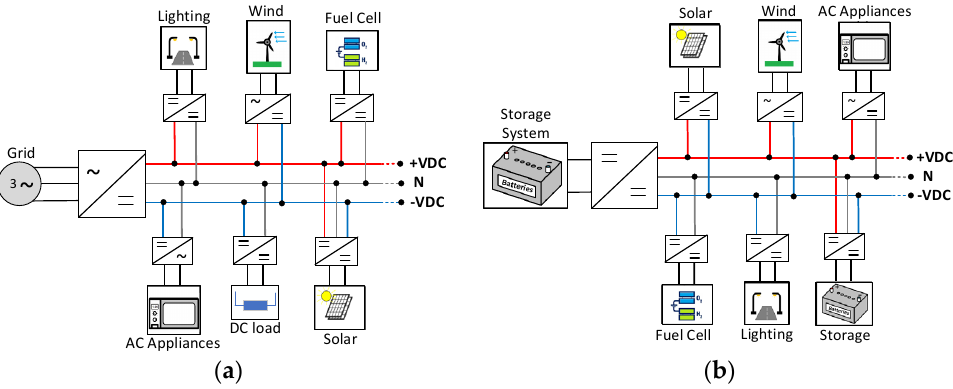
Figure 7. A schematic of typical example of the bipolar configuration: ( a ) connected to the grid and ( b ) operating in island mode.